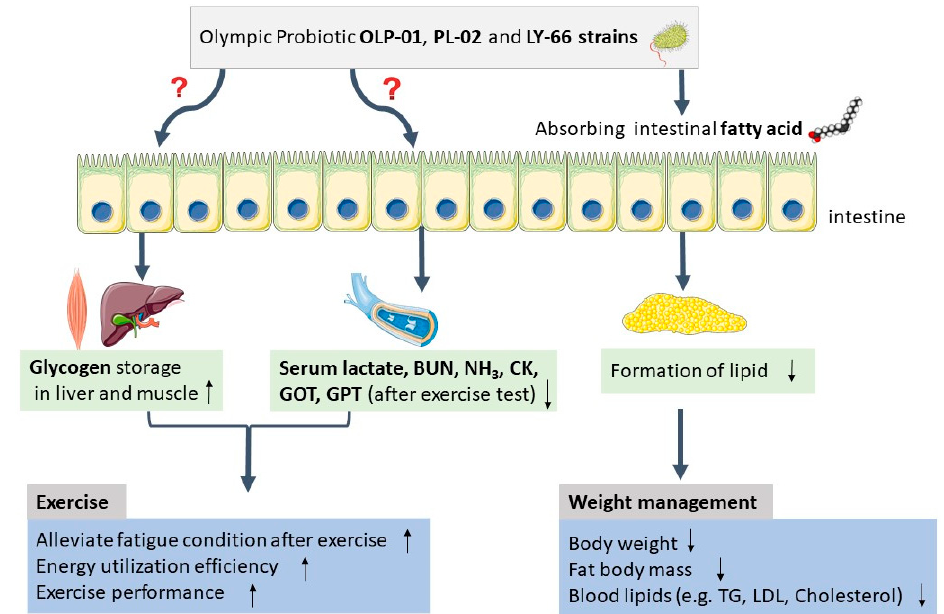
Figure 5. Hypothesis of mechanism through which supplementation with Olympic gold medalist- derived probiotic strains facilitate exercise performance and body weight loss. The upward arrow indicates increasing tendency, whereas the downward arrow indicates decreasing tendency.